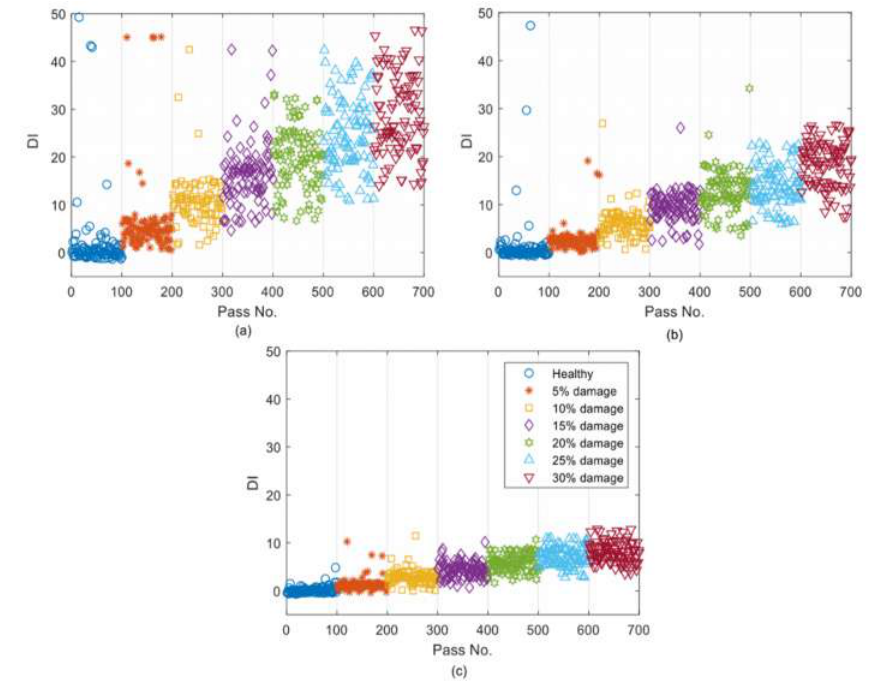
Figure 15. The DIs for ( a ) 1% added noise, ( b ) 3% added noise, and ( c ) 5% added noise.